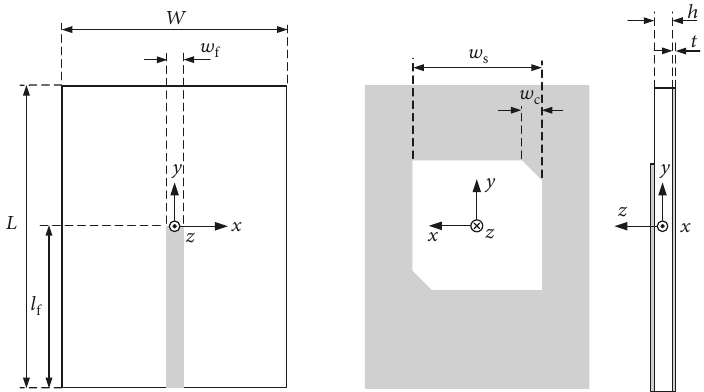
Figure 1: Initial design of the truncated square patch antenna (front view, rear view, and side view).